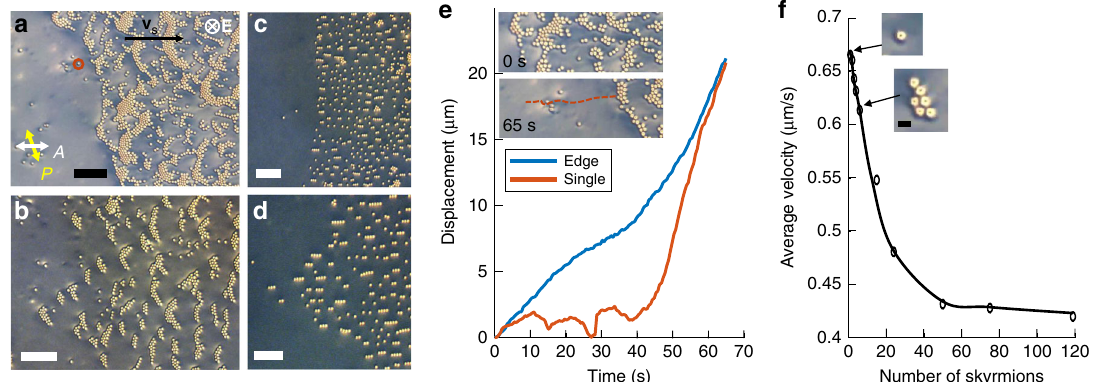
Fig. 6 Edges of dynamic skyrmion schools. a Polarizing micrograph, extracted as a still frame from Supplementary Movie 6, displaying the edge of a school of skyrmions. b – d Polarizing micrographs displaying different well-de fi ned school boundaries. The scale bars in a – d are 100 µ m. e Displacement of a single skyrmion compared to the school ’ s edge, derived from frames of the Supplementary Movie 6, with insets showing the moving edge with time. The trajectory of a single skyrmion (highlighted with an orange circle) in a as it catches up to the edge is shown in the lower inset with an orange dotted line. f Velocity of the skyrmion clusters versus the number of constituent skyrmions within the schools. The directions of v s , uncrossed polarizer and analyzer (double arrows) and E are the same throughout as marked in a . The motion takes place at f = 50 Hz and a , c U = 3.5 V and b , d U = 4.0 V. The chiral LC mixture is ZLI-2806 doped with CB-15 (Table 1)